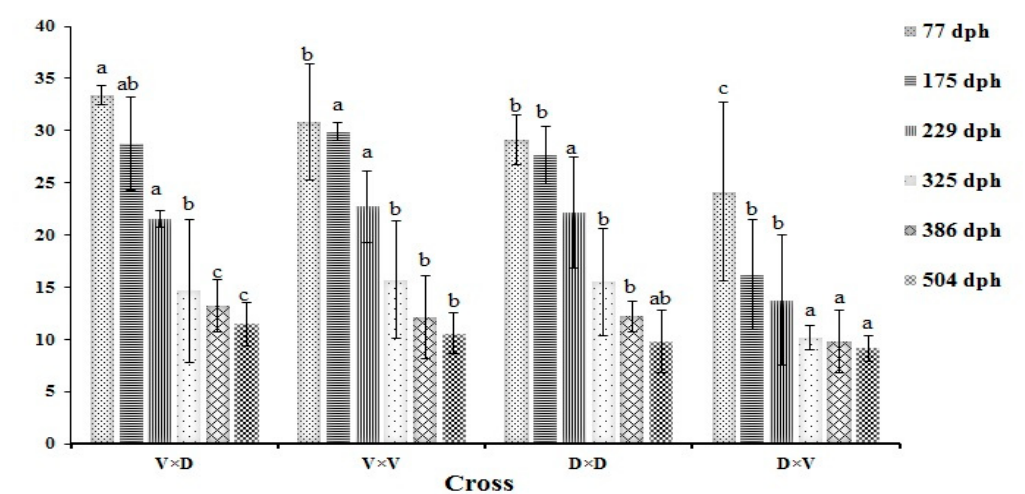
Figure 4. Observed values of cumulative survival (% mean ± SD) among the analyzed hybrid and purebred sterlet at selected days post-hatching (dph). Di ff erent superscripts within a row indicate significant di ff